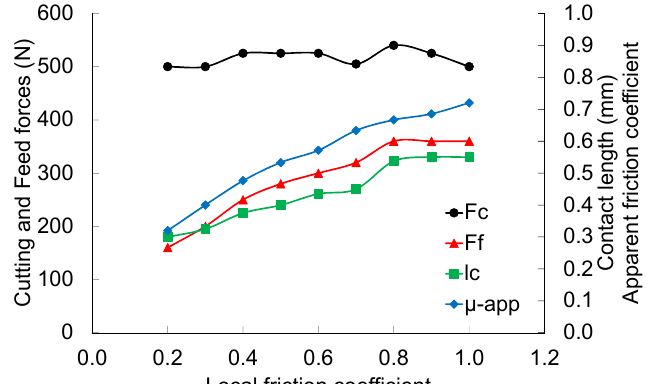
Figure 15. Evolution of average cutting and feed forces, apparent friction coefficient, and average contact length with COF.